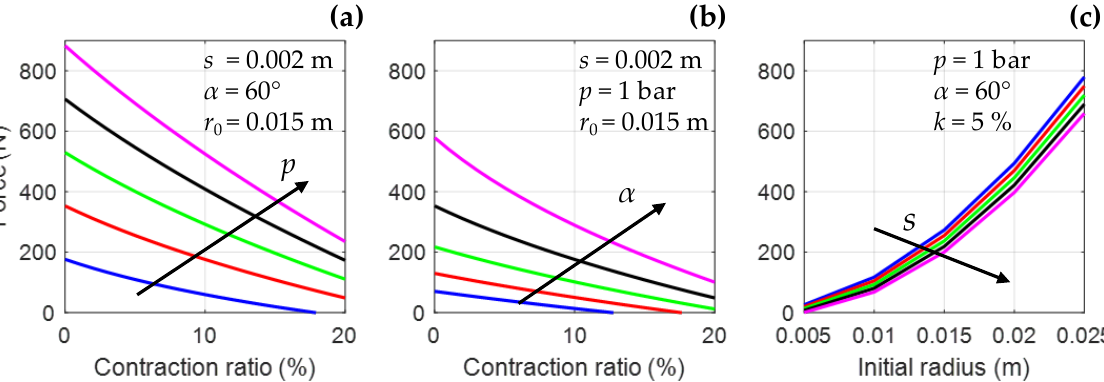
Figure 2. Traction force of McKibben’s muscle for different geometrical and functional parameters. ( a ) The MKM tensile force for different supply pressure p [0.5; 1; 1.5; 2; 2.5] bar; ( b ) The MKM tensile force for different winding angle α of the inextensible fibers [45; 50; 55; 60; 65]°; ( c ) The MKM tensile force for different thickness s of the inflatable chamber [1; 2; 3; 4; 5] mm. The nominal length has been set to 0.2 m for all simulations. In the graph r 0 is the resting radius; k is the contraction ratio. The relationship between the said parameters and the traction force is not linear.